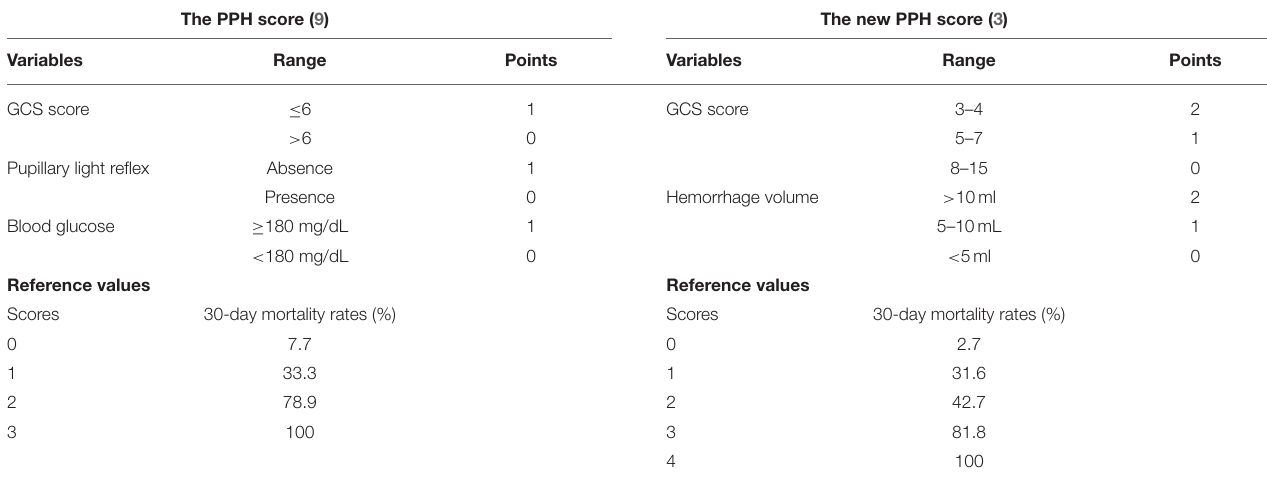
TABLE 2 | Grading standards of the PPH score and the new PPH score. The PPH score